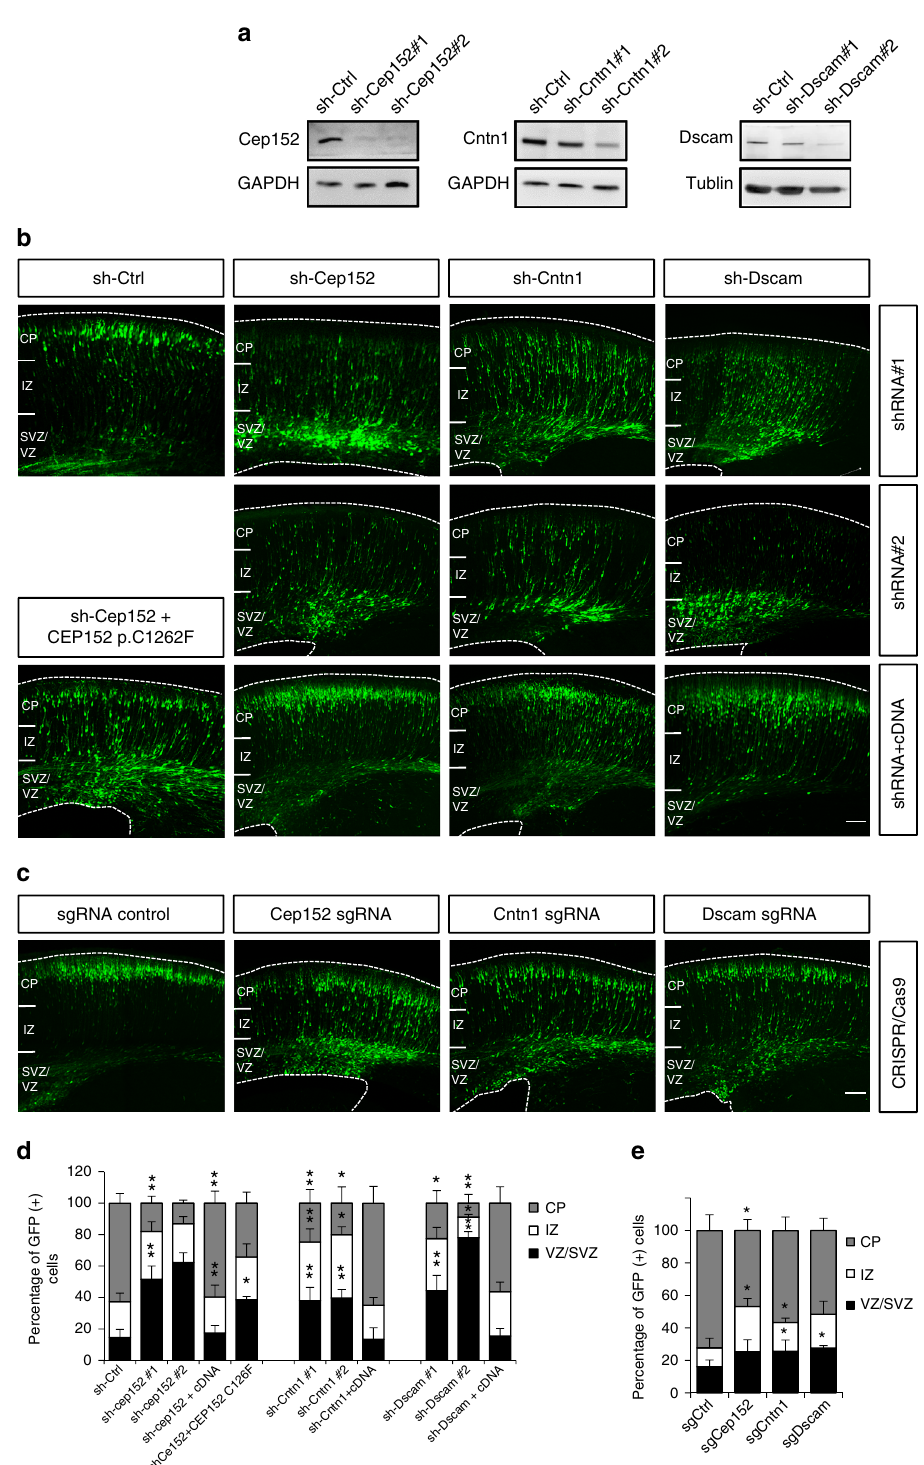
Fig. 5 Neuronal distribution after knockdown and disruption of candidate genes. a Knockdown ef fi ciency of shRNAs targeting candidate genes by western blot. b Distribution of cells in brains electroporated with shRNAs against candidate genes at E14.5 and imaged 4 days later at E18.5. Two shRNAs against each genes were used for each genes. Brains electroporated with shRNAs targeting Cep152 , Cntn1 , and Dscam all altered neuron distribution with the accumulation of GFP + cells in the VZ/SVZ compared to the control brain. c Overexpression of these genes rescue the phenotype caused by shRNA in the same condition. d Distributions of cells in brains electroporated with shRNAs, and rescue constructs. n = 3 animals for each group. *: p < 0.05, **: p < 0.01, Student ’ s t test. e Disruption of these three genes with CRISPR/Cas9 technology using electroporation of sgRNA also showed ectopic GFP + cells in the SVZ/VZ and IZ. n = 3 animals for each group. *: p < 0.05, Student ’ s t test. Bars = 100 μ